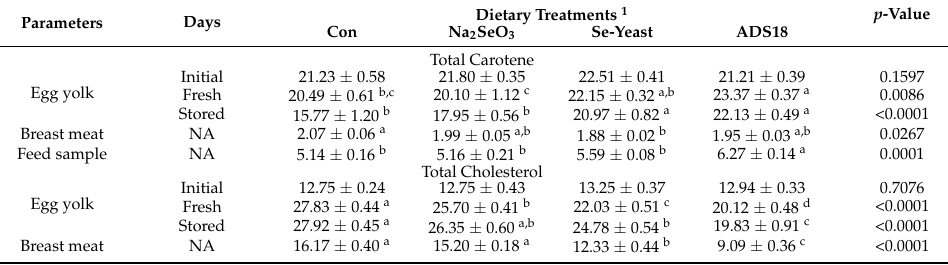
Table 3. Total carotenoid (mg/g of β -carotene) and total cholesterol (mg/g) content pre- and post- storage at 4 ± 2 ◦ C for 2 weeks of laying hens supplemented with inorganic selenium and different organic Se sources.